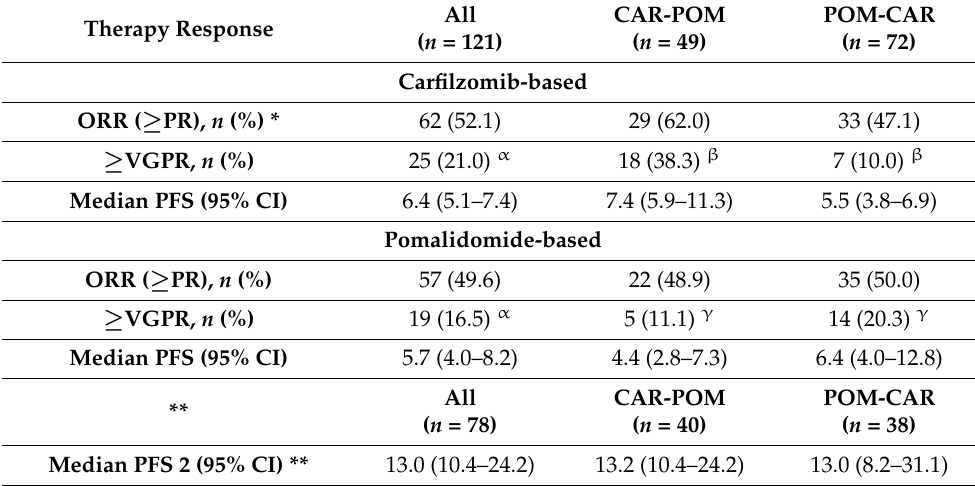
Table 2. Therapy responses of carfilzomib- and pomalidomide-based therapies in the CAR-POM and POM-CAR groups.